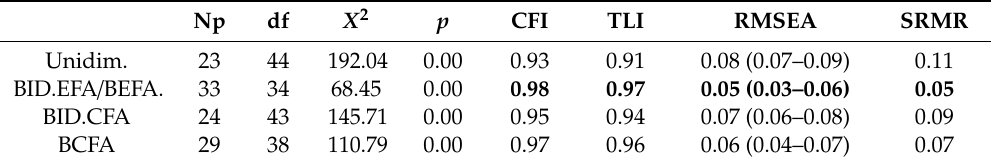
Table A3. Model fit indices for all tested models.